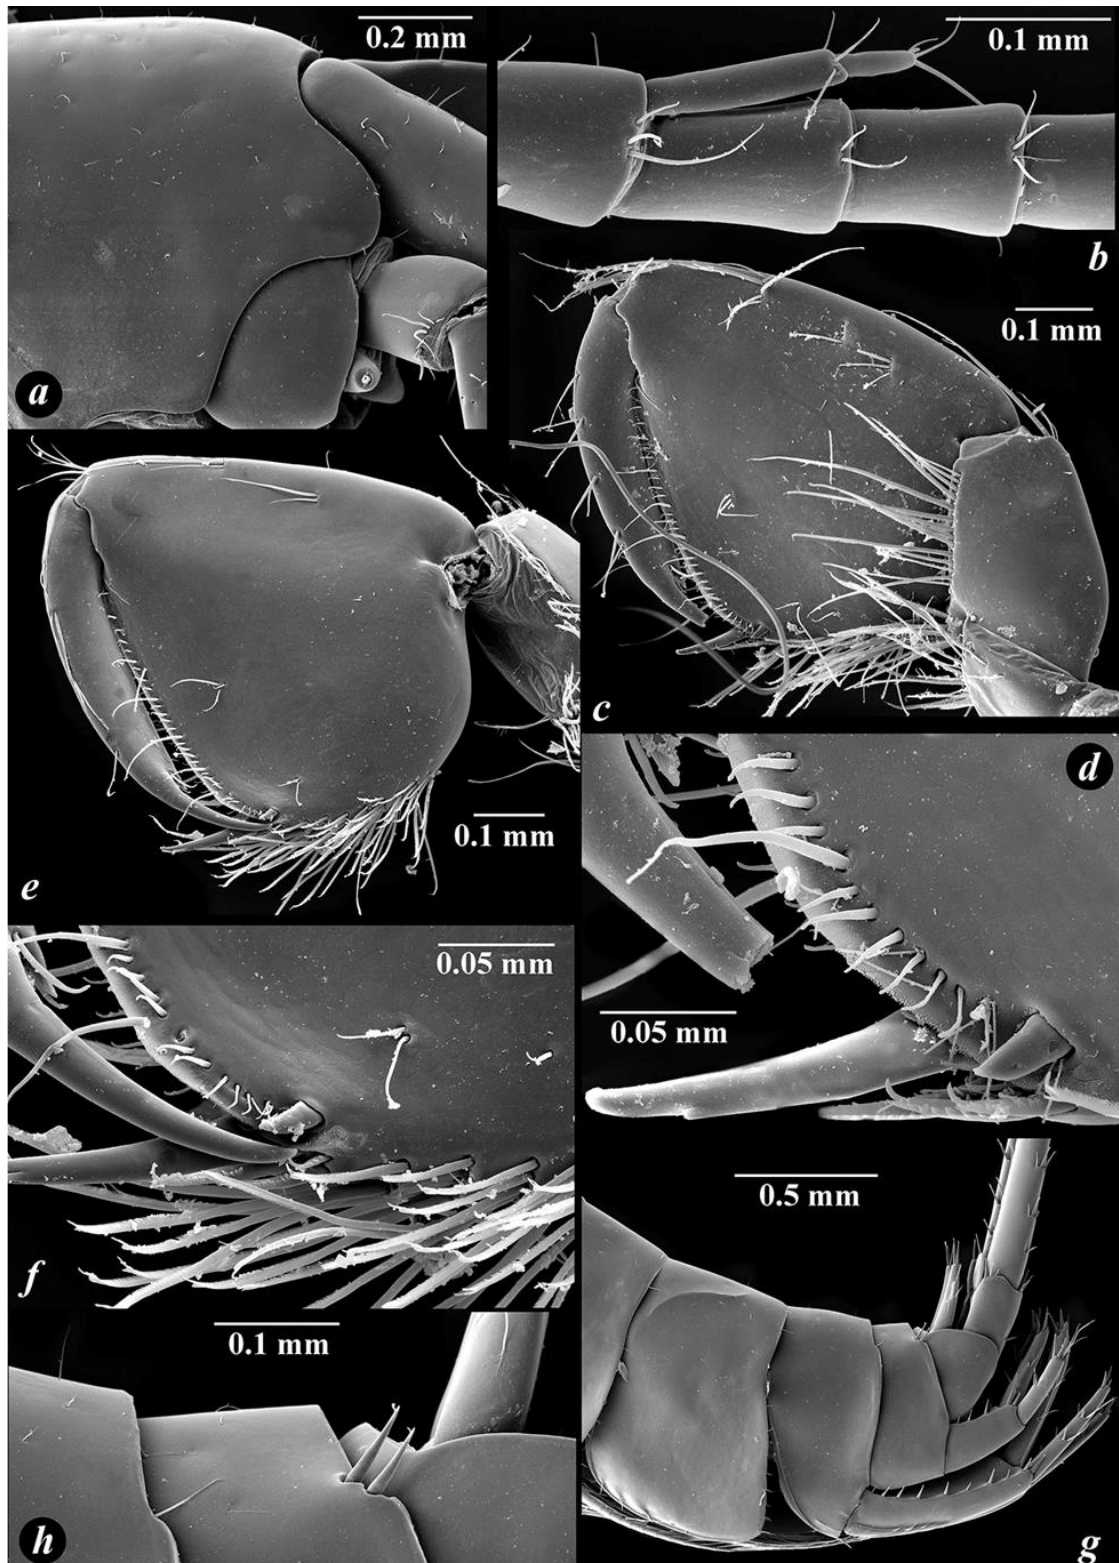
Figure 7. Niphargus tarkhankuticus sp. nov., male: ( a ) head; ( b ) accessory flagellum of antenna I; ( c ) gnathopod I; ( d ) distoventral corner of GnI; ( e ) gnathopod II; ( f ) distoventral palmar margin of GnII; ( g ) urosomal segments and uropods; ( h ) dorsal surface of urosomal segments.